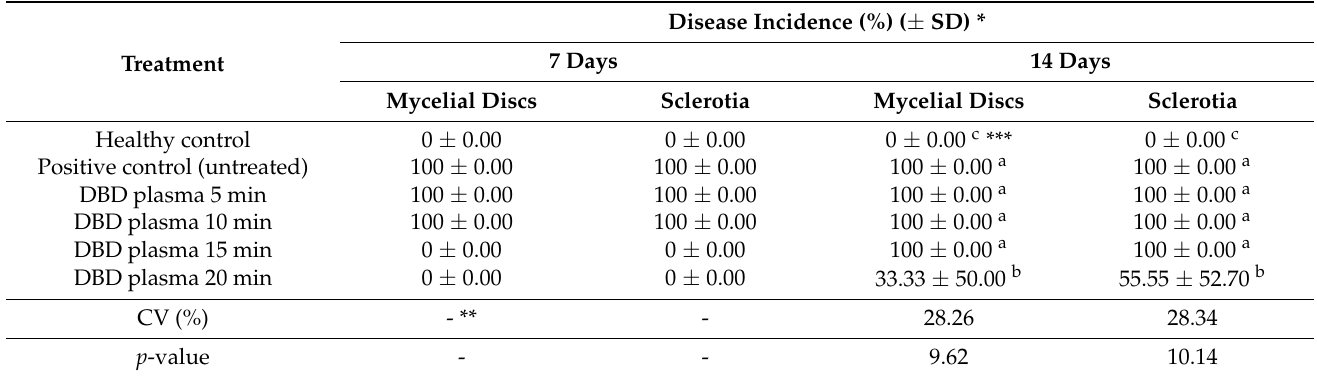
Table 2. Disease incidence of southern blight on lettuce caused by Athelia rolfsii after DBD plasma exposure for different durations.